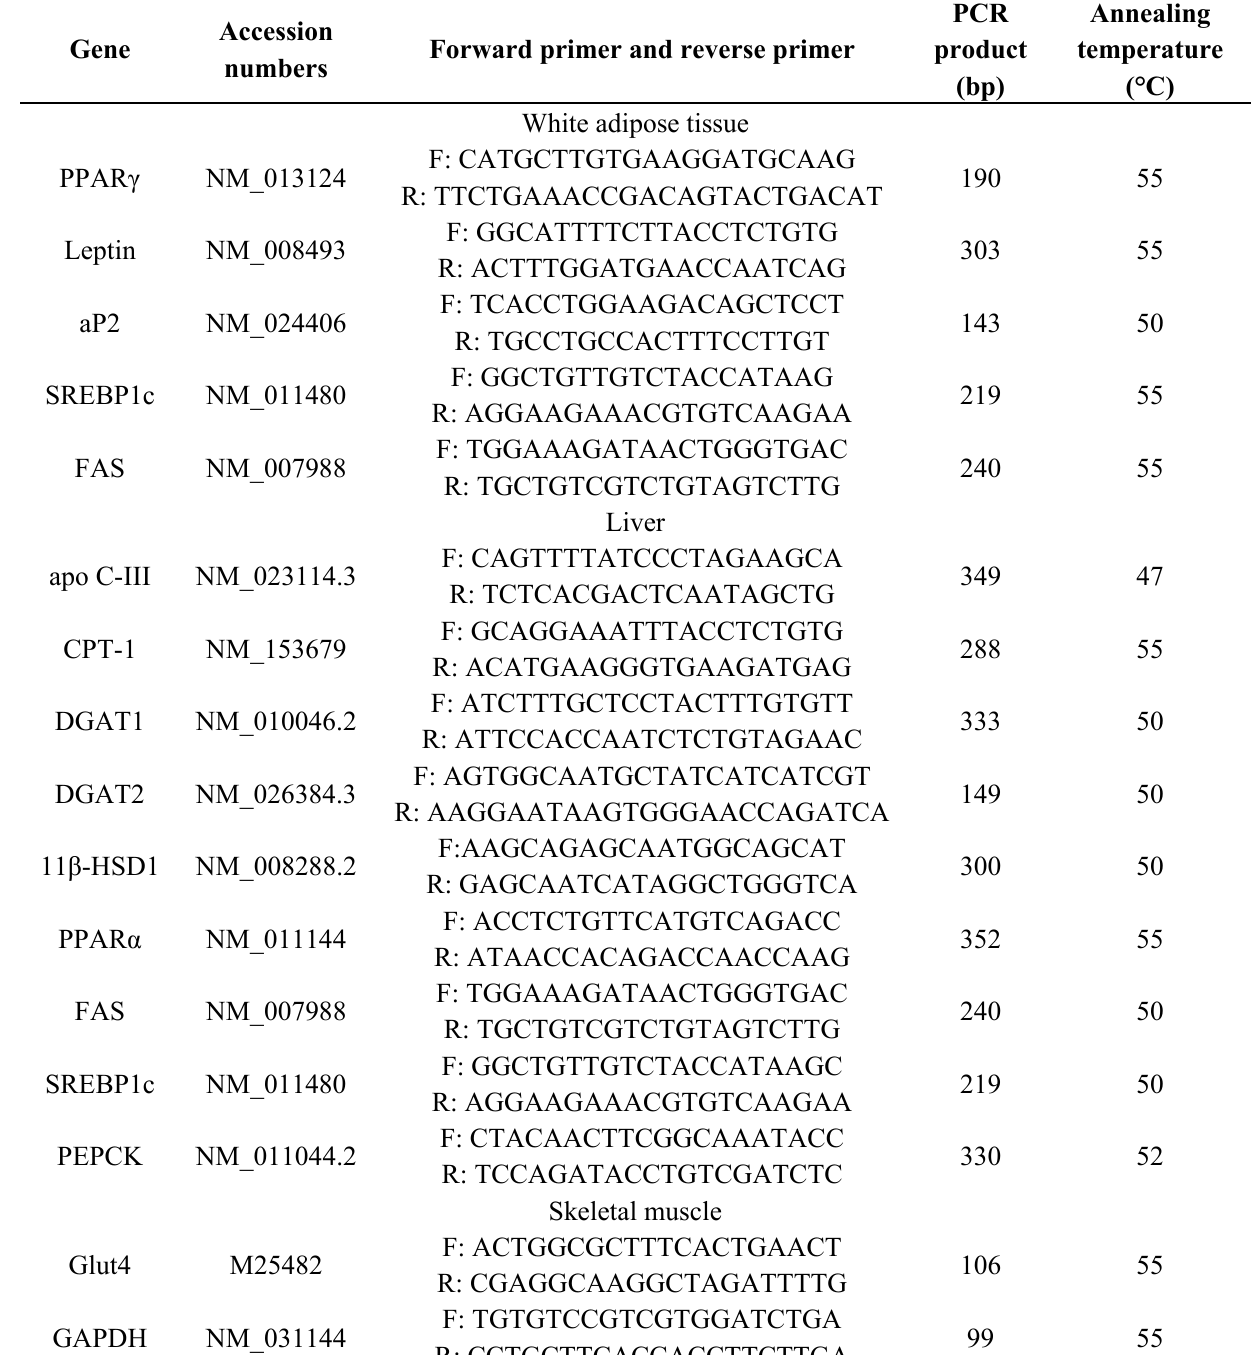
Table 4. Primers used in this